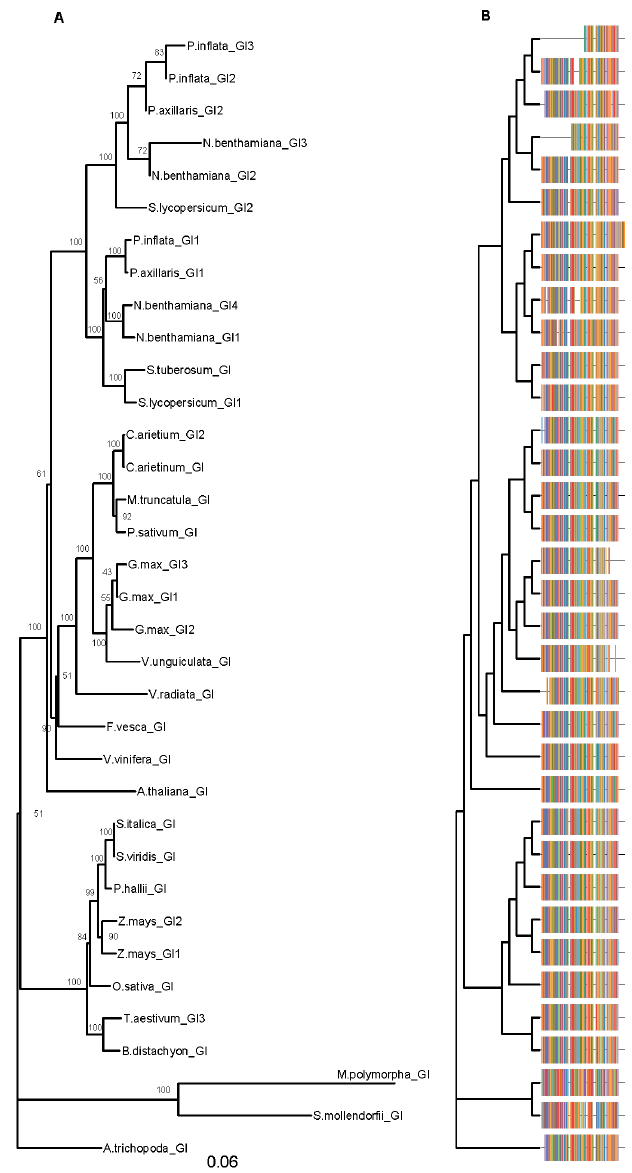
Genes 2019 , 10 , x; doi: FOR PEER REVIEW Phylogenetic analysis was performed using MEGA X and trees were plotted with the library “ggtree” (R version 3.5.1). The phylogenetic trees were built with the neighbor-joining method (NJ) and JTT (Jones, Taylor and Thornton) as model of amino acid substitution. The tree displays the bootstrap percentage (from 500 replicates) next to branches ( A ). The multiple sequence alignment is displayed on the right side ( B ). This tree contains 35 sequences from 25 species. Species abbreviations: A.majus ( Antirrhinum majus ), A.thaliana ( Arabidopsis thaliana ), A.trichopoda ( Amborella trichopoda ), B.distachyon ( Brachypodium distachyon ), C.arietinum ( Cicer arietinum ), F.vesca ( Fragaria vesca ), G.max ( Glycine max ), M.polymorpha ( Marchantia polymorpha ), M.truncatula ( Medicago truncatula ), N.benthamiana ( Nicotiana benthamiana ), O.sativa ( Oryza sativa ), P.axillaris ( Petunia axillaris ), P.hallii ( Panicum hallii ), P.inflata ( Petunia inflata ), P.sativum ( Pisum sativum ), S.italica ( Setaria italica ), S.lycopersicum ( Solanum lycopersicum ), S.moellendor ffi i ( Selaginella moellendor ffi i ), S.tuberosum ( Solanum tuberosum ), S.viridis ( Setaria viridis ), T.aestivum ( Triticum aestivum), S.italica (Setaria italica), V.radiata (Vigna radiata), V.unguiculata ( Vigna unguiculata ), V.vinifera ( Vitis vinifera ) and Z.mays ( Zea mays ). Accessions are listed in Table